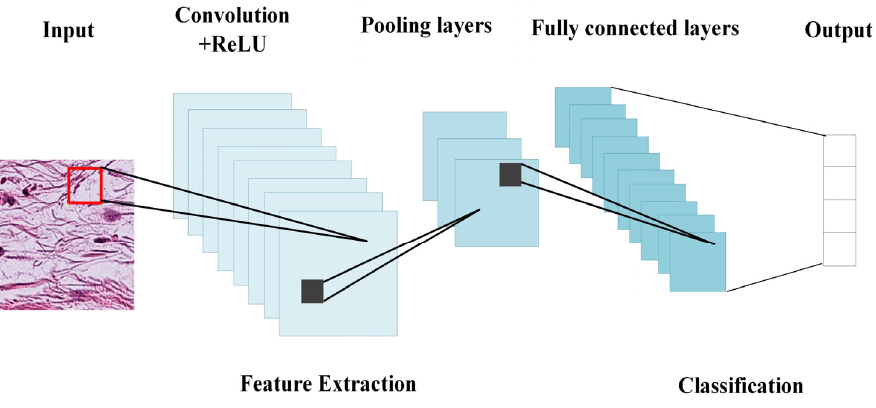
Figure 2. Network architecture of CNN.